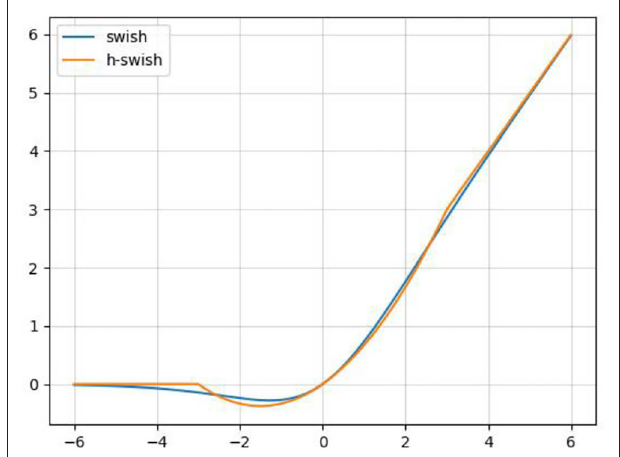
FIGURE 5 | Schematic diagram of the sigmoid and h-sigmoid activation functions. FIGURE 6 | Schematic diagram of the swish and h-swish activation